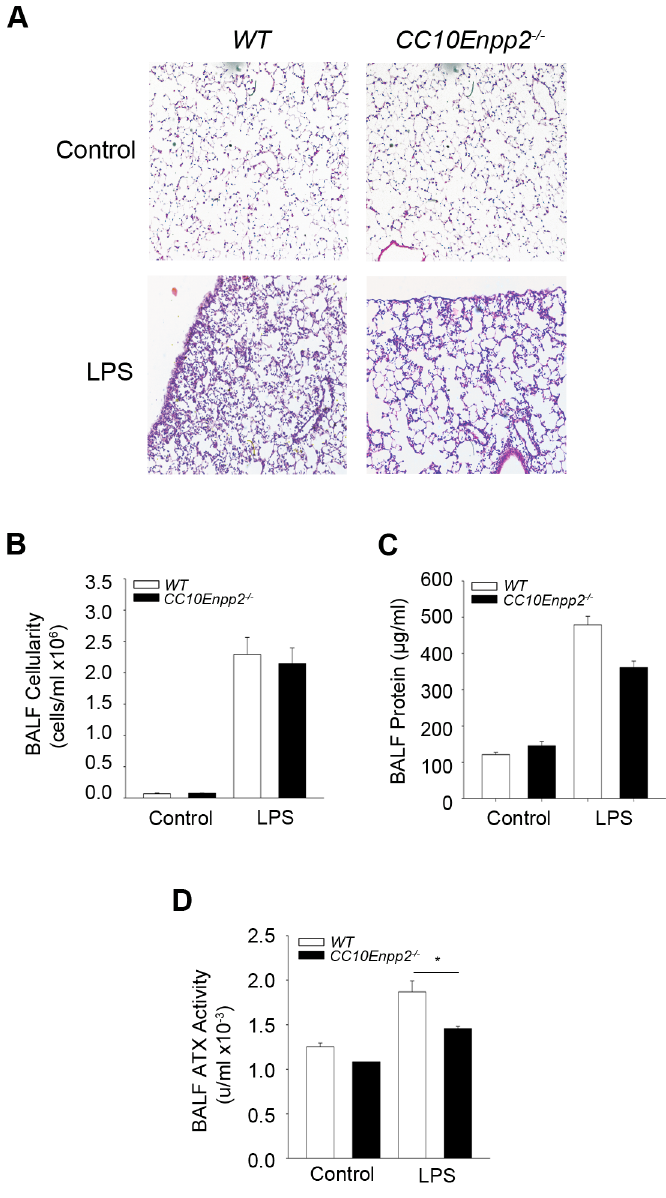
Fig 2. Genetic deletion of ATX from the bronchial epithelium has minor effects in ALI development. Aerosolized LPS was administered in mice where ATX was genetically deleted specifically from bronchial epithelial cells (CC10Enpp2 -/- ), as well as wild type littermates. Mice were sacrificed 24 hours later (n = 3 – 8; a representative experiment out of two is shown). A-C. Histological analysis (A) and BALF measurements (B & C) indicated no significant changes in the lungs of mice lacking ATX expression in the bronchial epithelium in comparison to their wild type littermates. D. Conditional deletion of ATX from the cells of the bronchial epithelium led to decreased enzyme activity of ATX in the